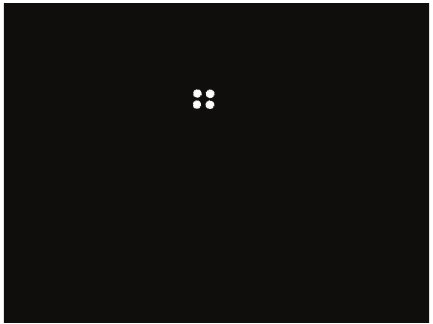
Figure 27: Variation in rectangle size with 𝑍 -distances.